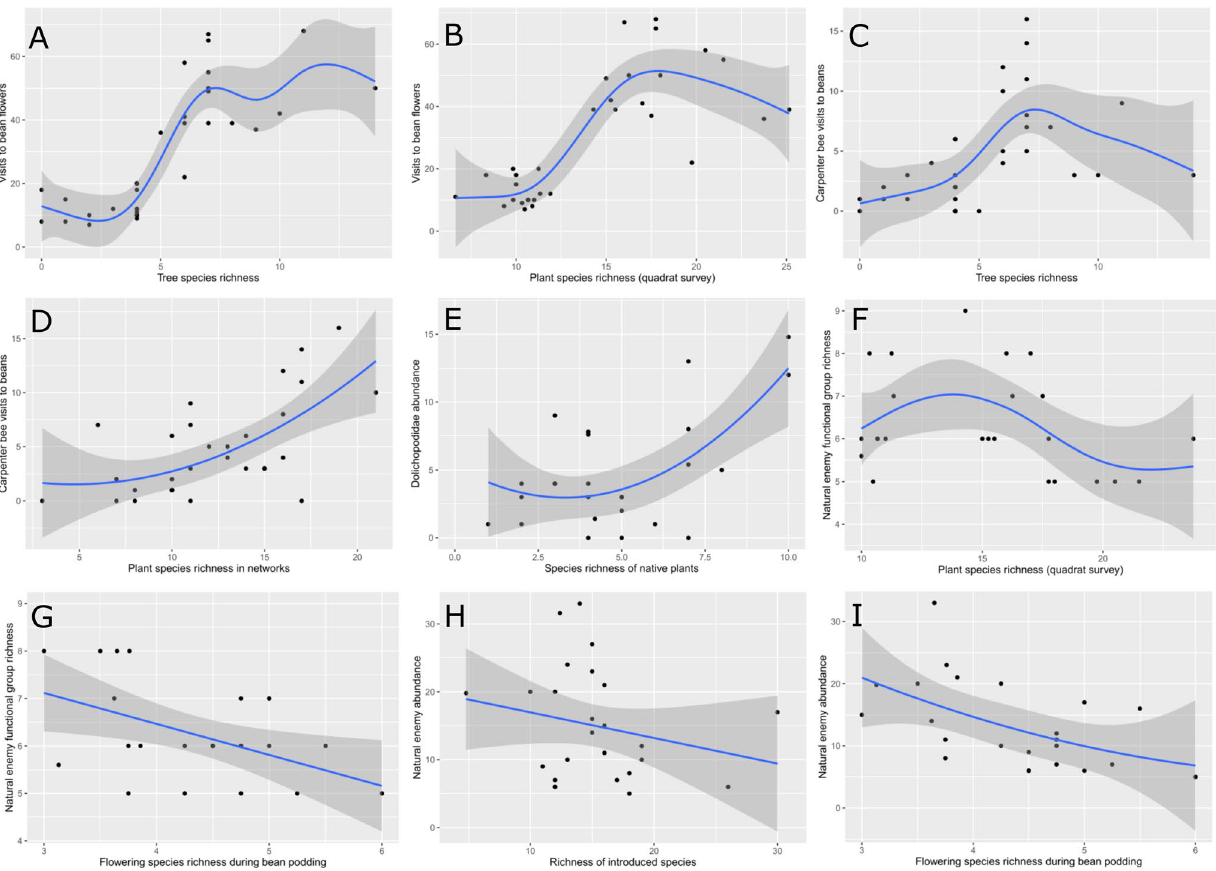
Figure 2. Regressions (where adjusted R 2 > 0.24) demonstrating the importance of plant and tree richness metrics in predicting pollinator visitation and natural enemy population measures and directionality of relationships. Factors influencing ( A ) and ( B ) all insect visits to beans; ( C ) and ( D ) carpenter bee ( Xylocopa spp.) visits to beans; ( E ) Dolichopodidae abundance; ( F ) and ( G ) natural enemy functional group richness; and ( H ) and ( I ) natural enemy overall abundance. Created in R 29 version 3.50 with ggplot2 30 and edited in GIMP version